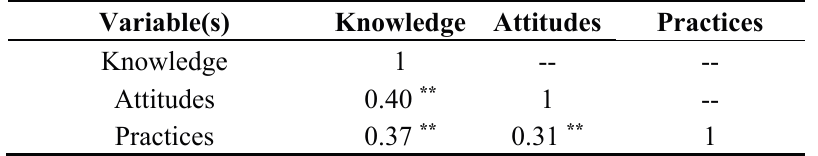
Table 6. Correlations between knowledge, attitudes, and practices in total